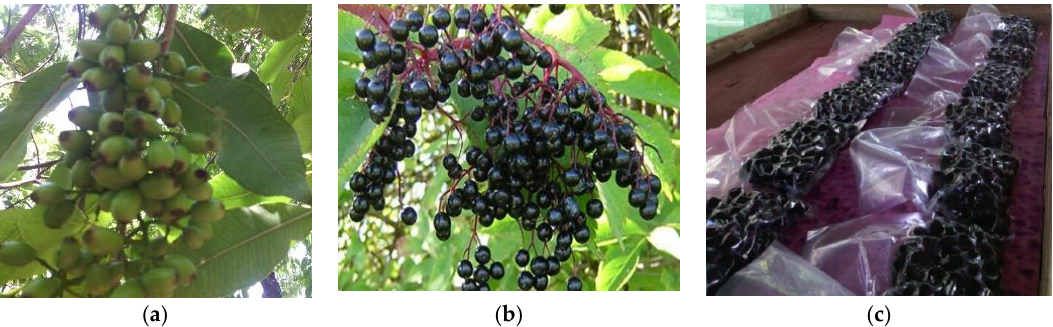
Figure 7. ( a ) A close up of immature chokecherries hanging from a tree; ( b ) a close up of mature chokecherries hanging from a tree; ( c ) frozen packaged chokecherries in vacuum